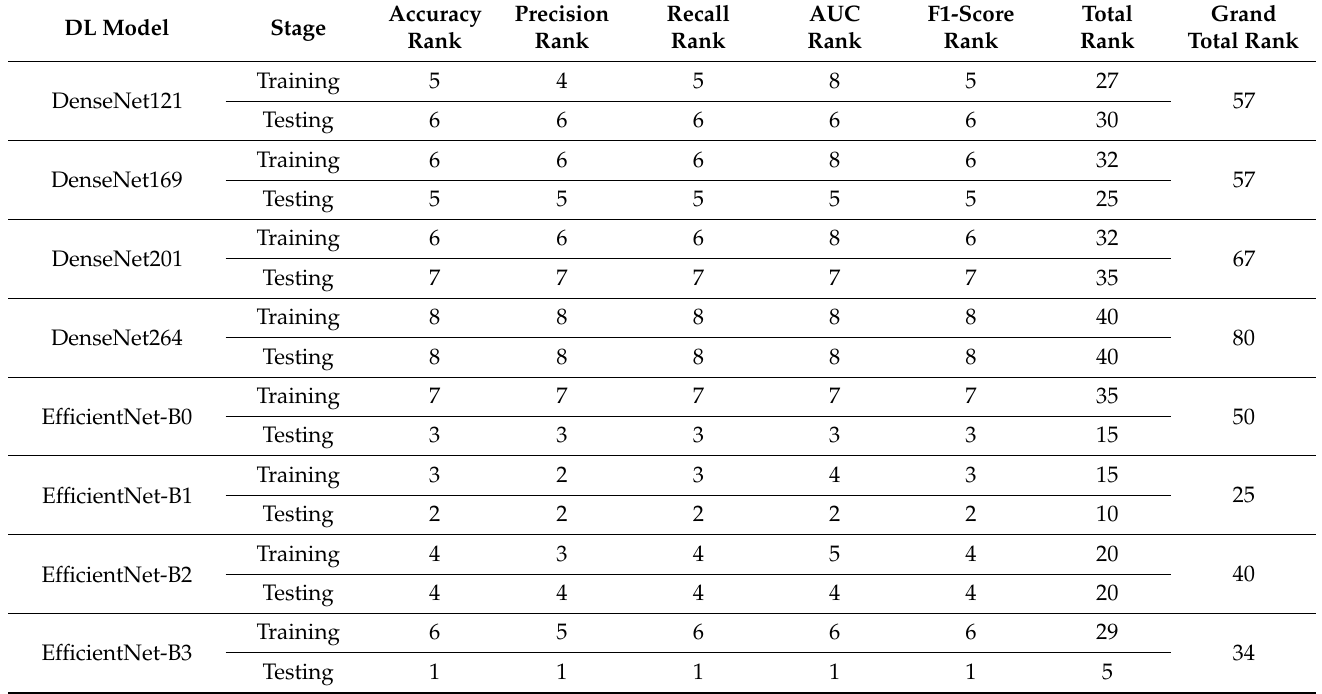
Table 10. The acquired rankings of all DL model performance indices for AD vs. CN